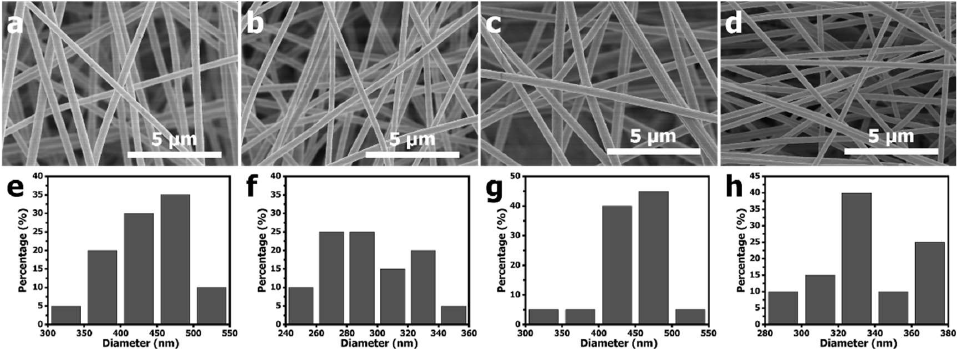
Figure 1. Scanning electron microscopy (SEM) images and diameter distributions of ( a , e ) polyacrylonitrile (PAN) 0%, ( b , f ) PAN-porous coordination network (PAN-PCN) 0.1%, ( c , g ) PAN-PCN 0.3% and ( d , h ) PAN-PCN 0.6% nanofiber membranes.